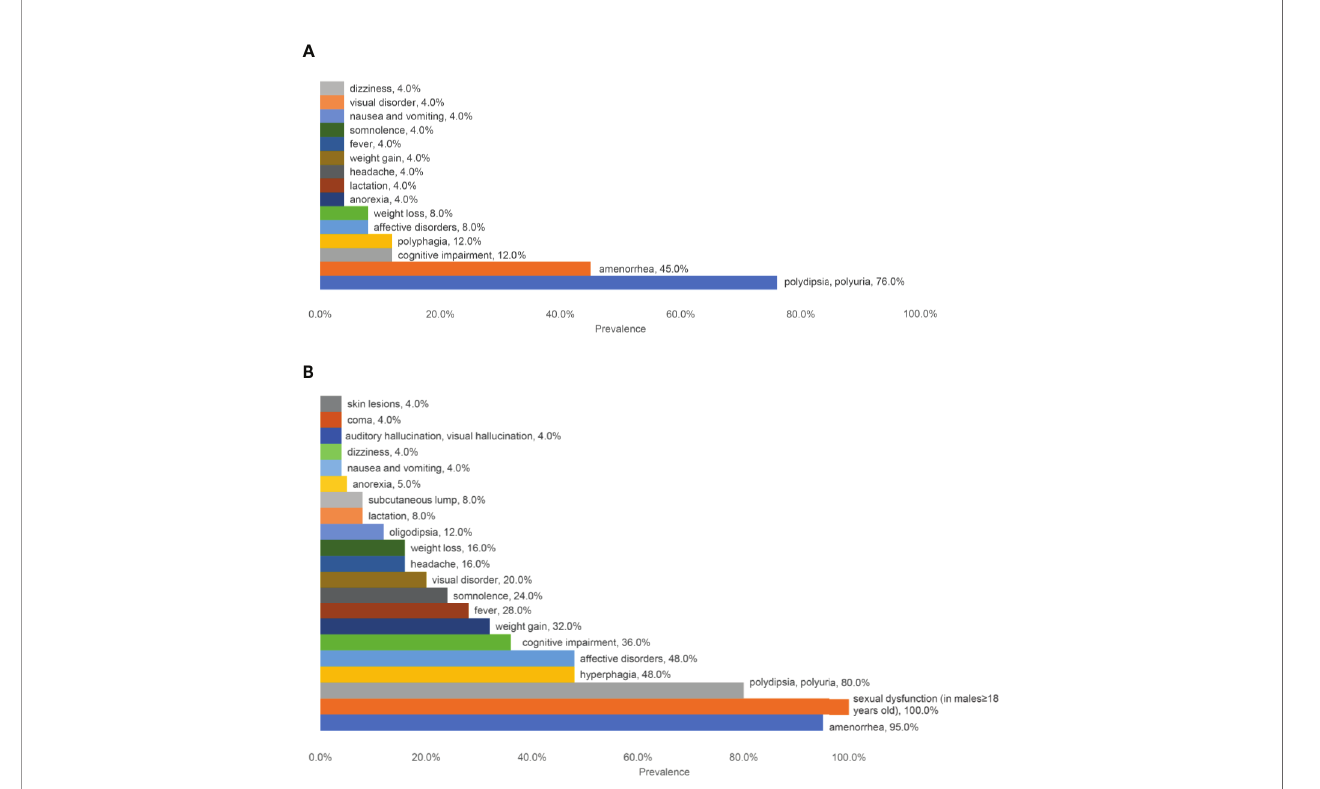
FIGURE 1 | A summary of the prevalence of different symptoms. (A) The prevalence of initial symptoms; (B) The prevalence of all the